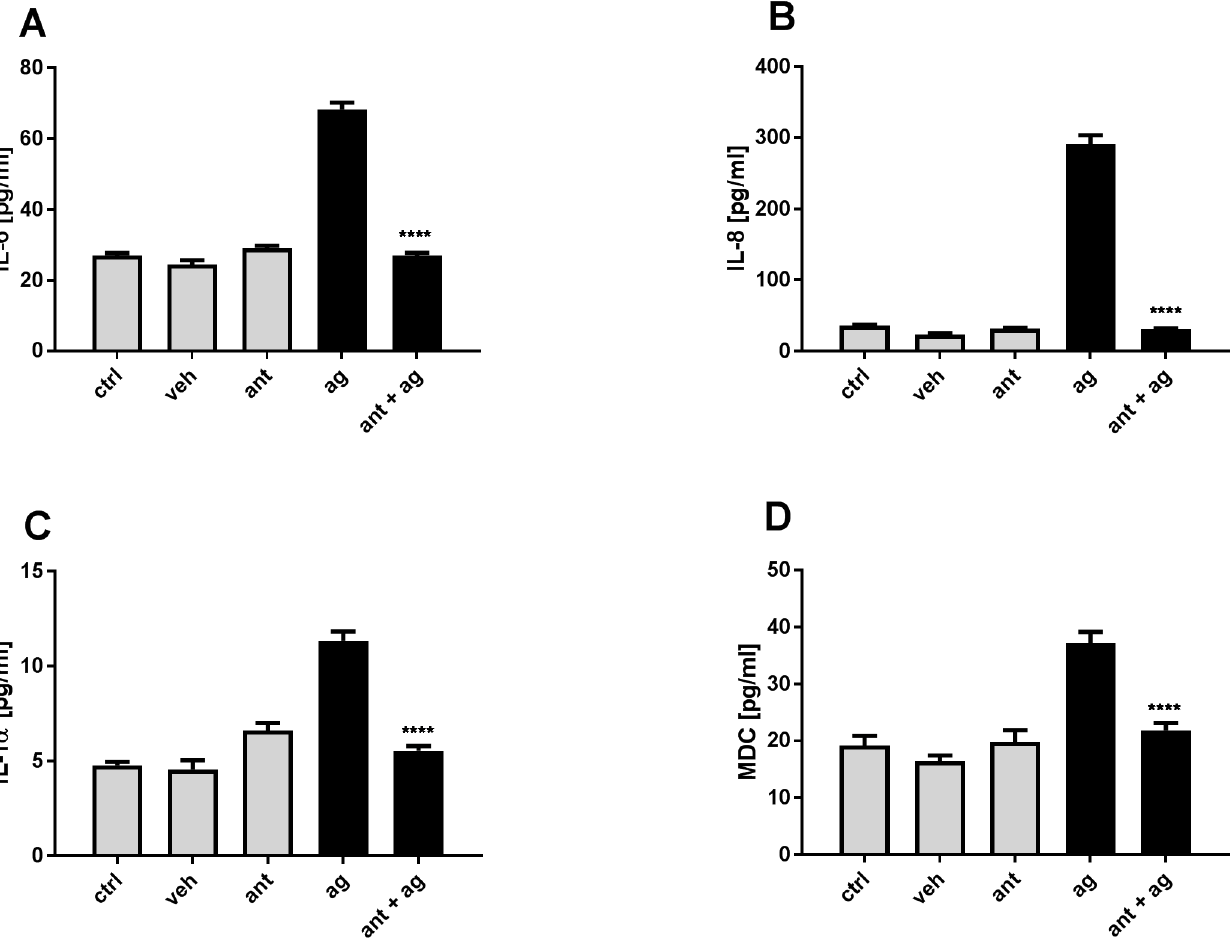
Fig 3. TRPV4 mediated cytokine release. Representative experiment of NCI-H292 cells incubated for 24 h in the presence or absence of the TRPV4 agonist GSK1016790A [3nM] (ag) with or without pre-treatment with the TRPV4-Antagonist GSK2193874 [1 μ M] (ant). (A,B) release of IL-6 and IL-8 through TRPV4 activation compared to medium (ctrl) and DMSO control (veh) that could be blocked by the TRPV4 antagonist. (C,D) TRPV4 mediated release of IL-1 α and MDC. Data are mean ± SEM; (n = 6; (cid:3)(cid:3)(cid:3)(cid:3) p < 0.0001 vs agonist control; one-way ANOVA Tukey’s multiple comparisons test).